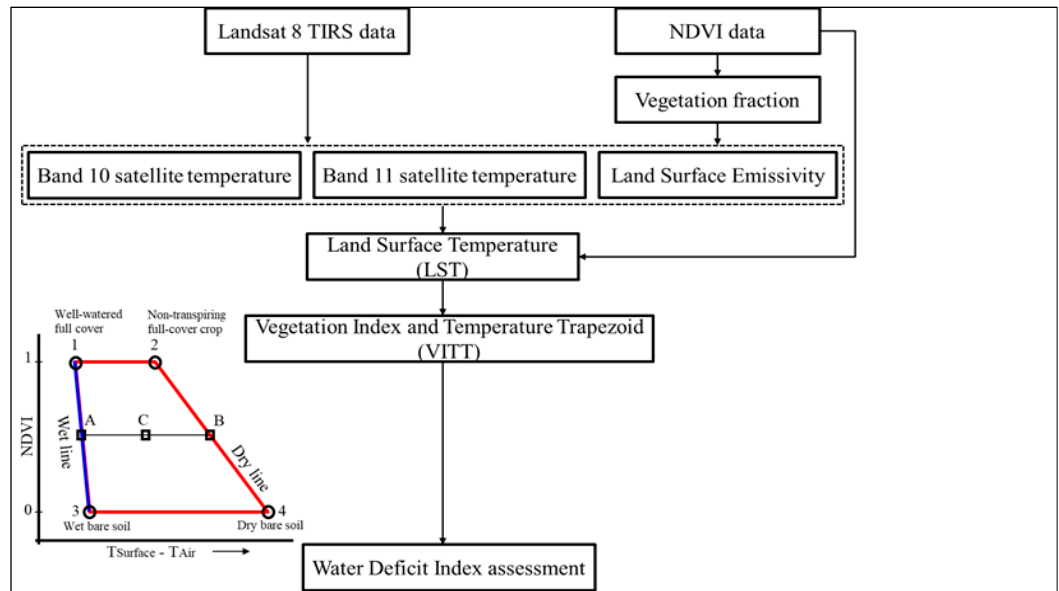
Figure 1. Flowchart of the methodology adopted for the estimation of land surface temperature and Water Deficit Index (WDI).